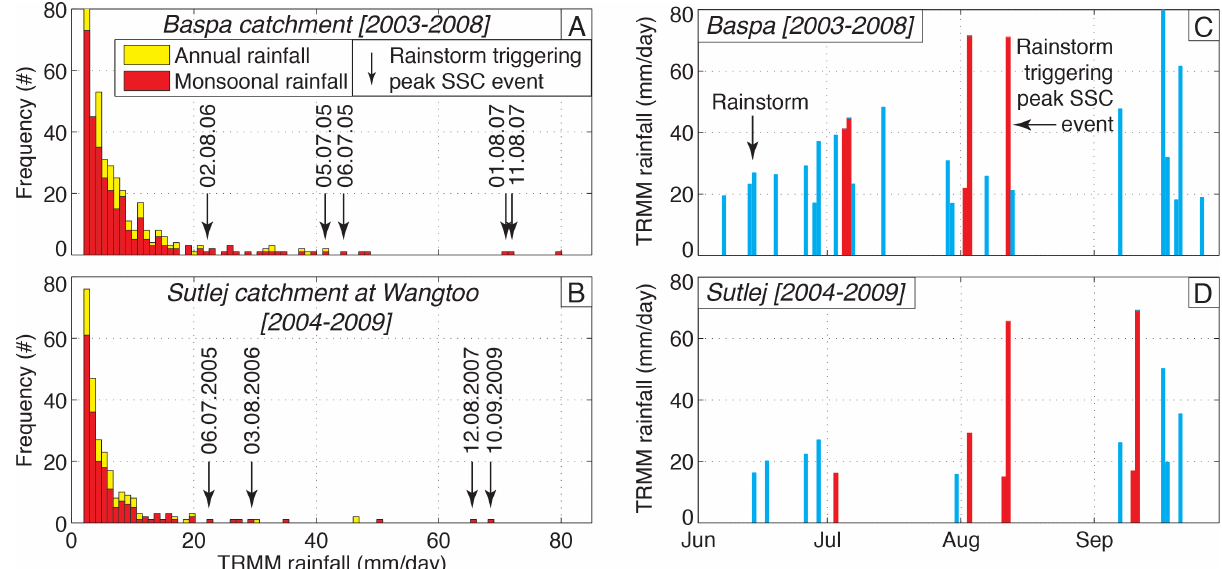
Fig. 7. Histograms of daily TRMM 3B42 data displaying annual and monsoonal (June–September) rainfall during the given time period for the Baspa catchment (A) and the Sutlej catchment at Wangtoo (B) . Arrows indicate rainstorms ( ≥ 90th rainfall percentile)that are associated with peak SSC days ( ≥ 99th SSC percentile). Panel (C) and (D) represent the 6-yr time series of rainstorms and their impact on peak SSC days during the monsoonal period for the Baspa catchment and Sutlej catchment at Wangtoo,